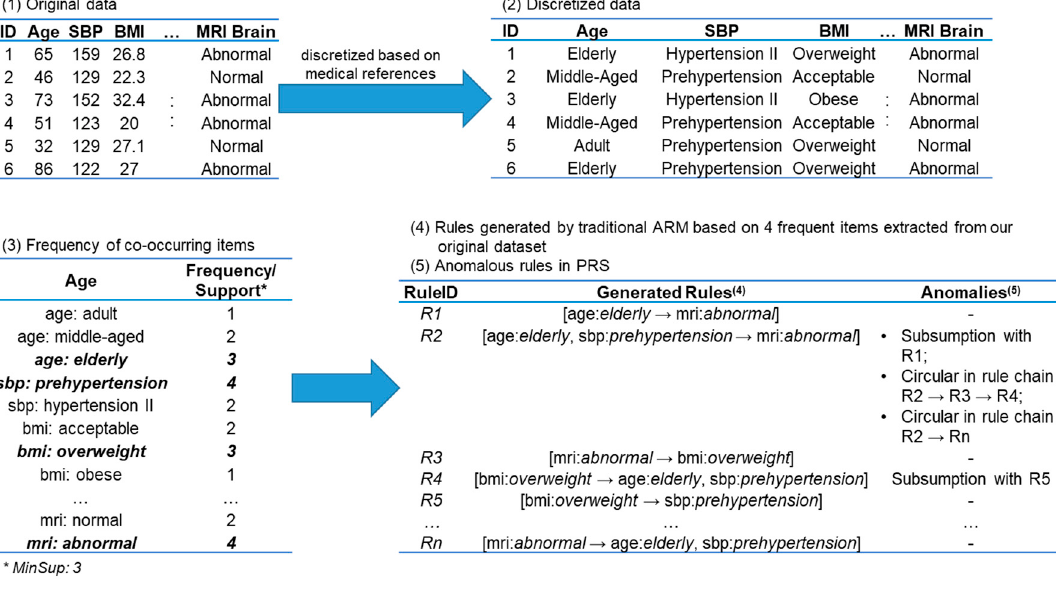
Figure 1. Case Illustration.